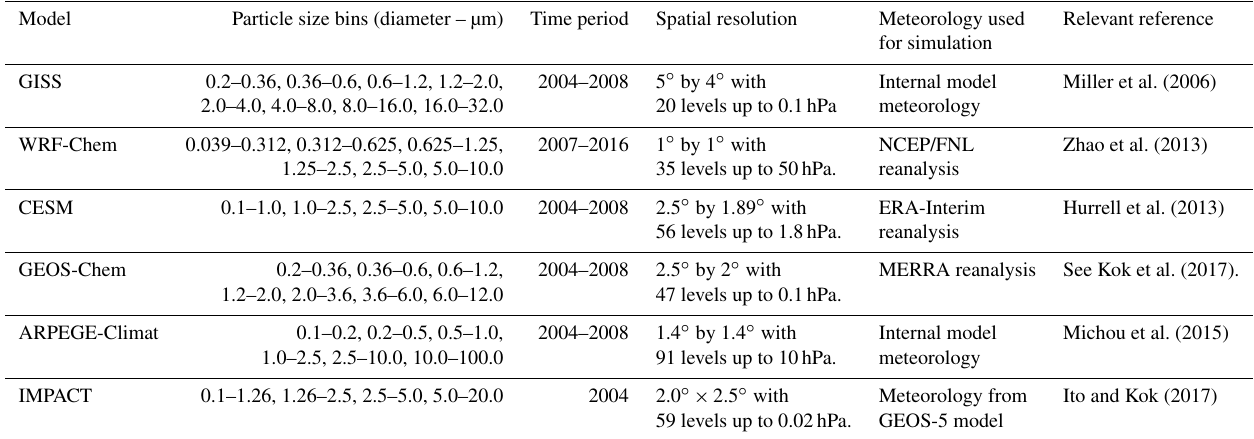
Table 1. Details of model simulations used in this study. Shown are the particle bin ranges, time periods of simulations, the spatial resolutions, the meteorology used, and the relevant model reference. We interpolate all model simulations to 2.5 ◦ by 1.9 ◦ to facilitate comparison and consistency with other datasets. See Sect. 2 for